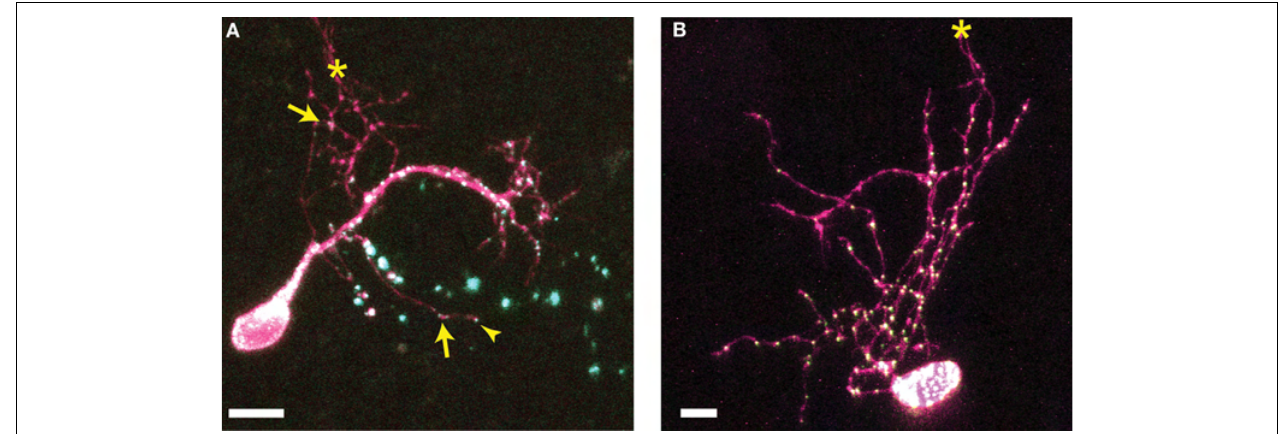
FIGURE 1 | Distribution of CPEB- and delCPEB-containing RNP granules in optic tectal neurons. Optic tectal neurons labeled with cytosolic YFP (magenta) and CPEB–CFP (A) or delCPEB–CFP (B) . CFP-tagged RNP granules are green puncta that when overlapping with magenta, appear white. Labeled RNP granules